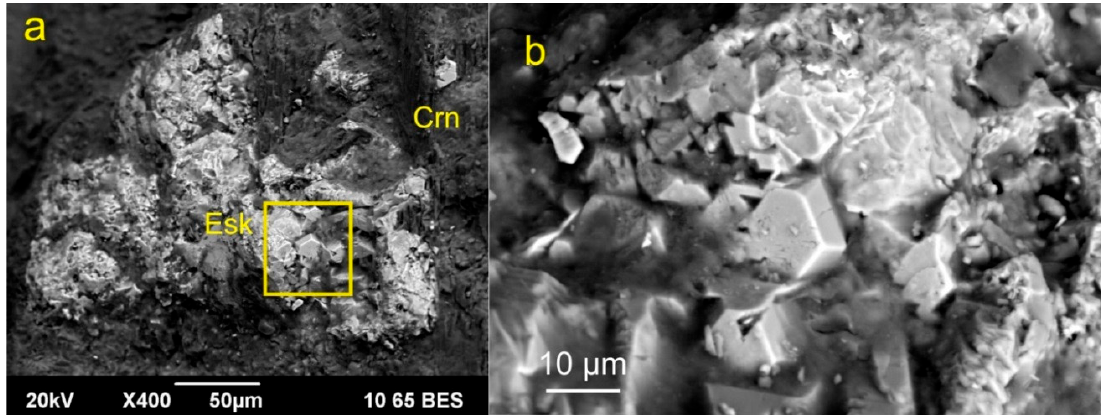
Figure 3. The aggregation of eskolaite crystals (Esk) on the surface of a ruby (Crn) crystal: ( a ) general view and ( b ) a close ‐ up of the yellow fragment depicted in Figure 3a.